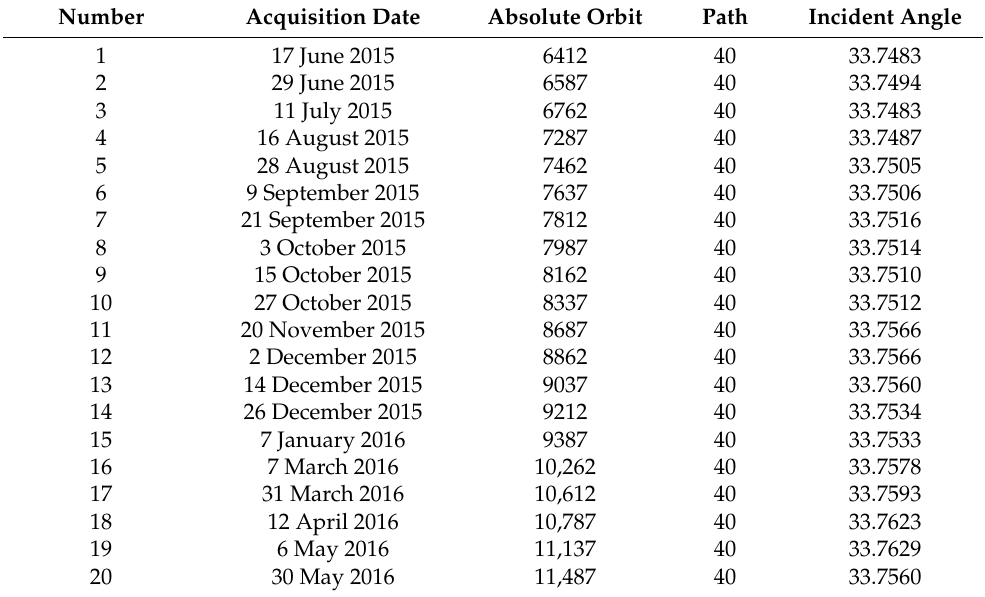
Table 1. Basic parameters of the Sentinel-1A